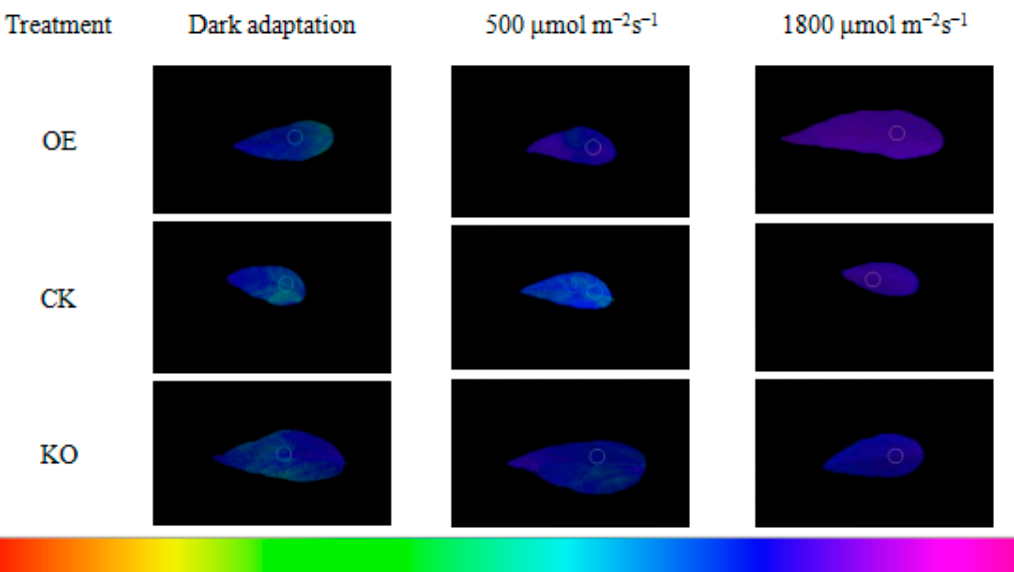
Figure 9. Effects of strong light stress on Chl fluorescence images of WT and the T 2 generation of GmRIQ2 - like- OE and -KO transgenic soybean seedlings.